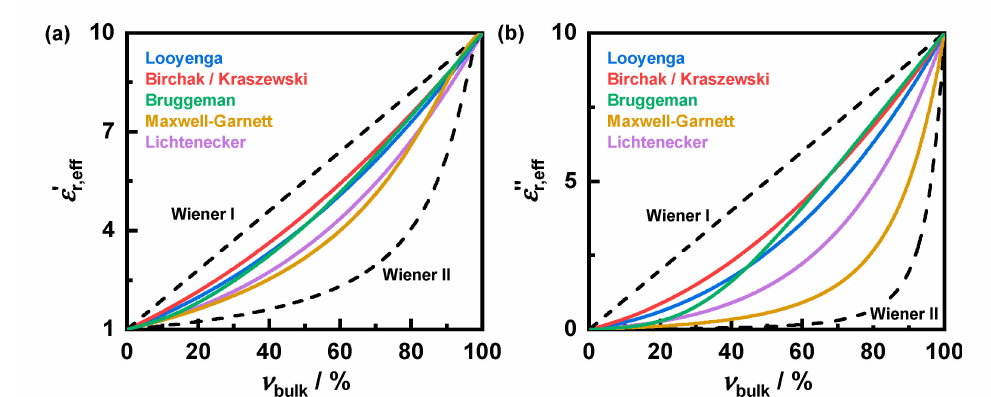
Figure 2. Example for application of different mixing rules on the effective permittivity ε (cid:48) ( a ) r,eff and the dielectric losses ε (cid:48)(cid:48) ( b ) depending on the bulk fraction ν bulk for mixtures of air ( ε (cid:48) = 1; r,air r,eff ε (cid:48)(cid:48) = 0) and lossy material (exemplarily values: ε (cid:48) = 10; ε (cid:48)(cid:48) = 10). Mixing rules according to r,air r,bulk r,bulk Looyenga [44], Birchak [45], Bruggeman [46], Maxwell-Garnett [47], Lichtenecker [48] and Wiener